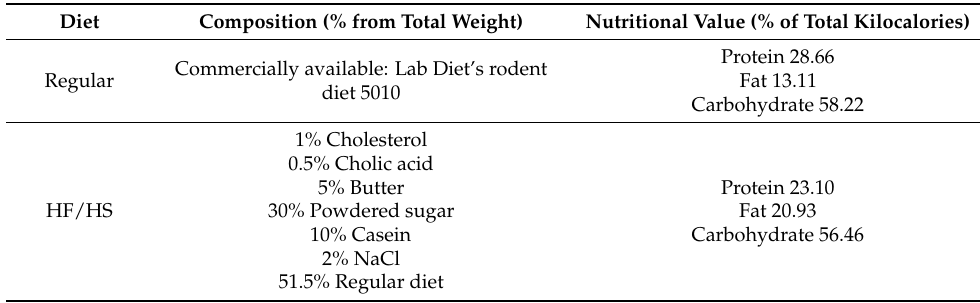
Table 1. Composition of regular and HF/HS